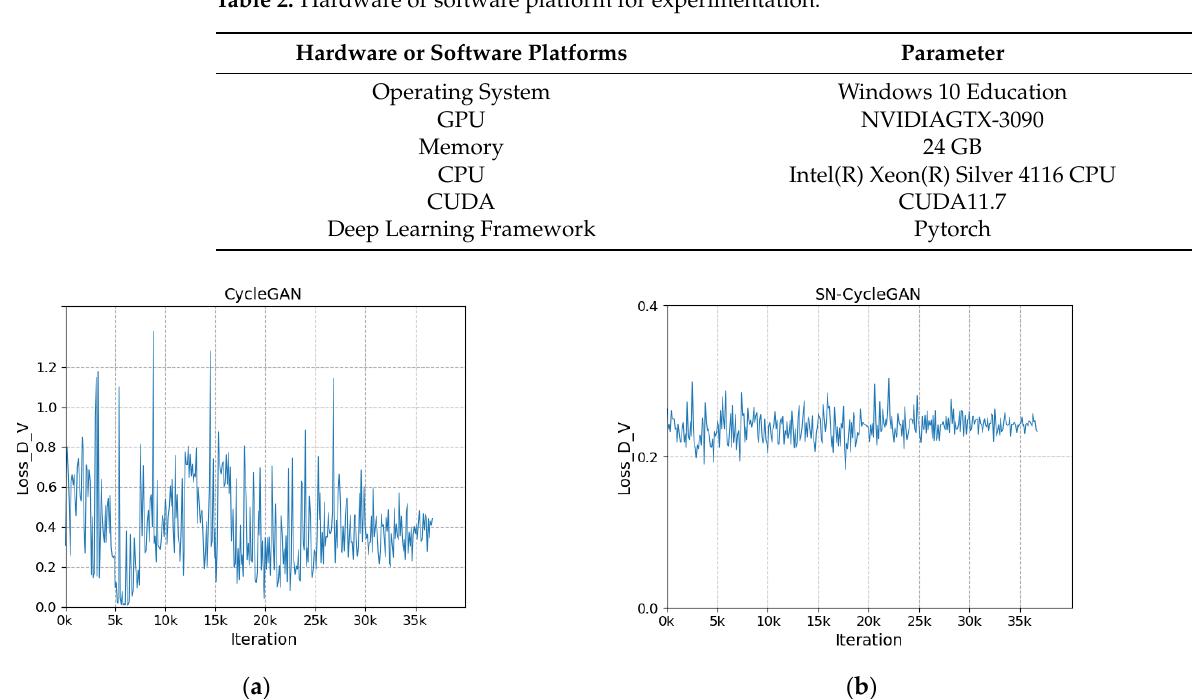
( b ) Figure 10. Comparison of generator loss for visible light. ( a ) CycleGAN, ( b ) SN-CycleGAN. 3.3.3. Weight Selection for Content Reconstruction Loss Function In this experiment, the weight of the content reconstruction loss function in SN-Cy- cleGAN is explored. We first test the weights over a larger range and then select the weights near the optimal weights for testing. We set the weights to 0, 5, 10, 15, 20 and 25, respectively, and as can be seen from Table 3, the value of FID is the smallest when the weight is 10. We selected 9 and 11 around 10 as the weights, and the FID values of the translated results were both maintained at 42. The trend for FID values is ‘ M ’ and FID at 10 is the minimum. Therefore, we choose 10 as the weight of the content reconstruction loss function. Table 3. FID value of content reconstruction loss under different weights. Weight